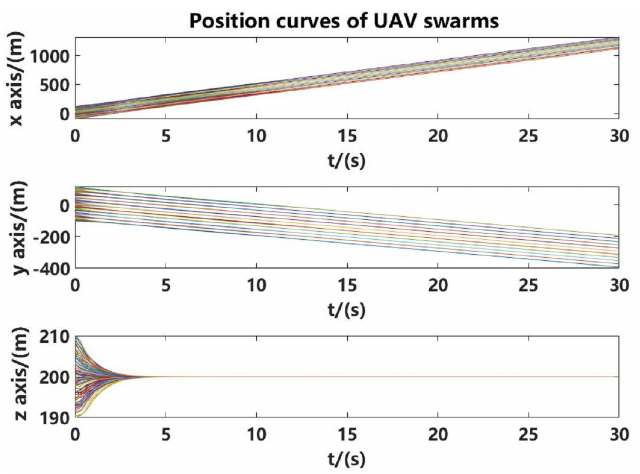
Figure 20. Position curves of UAV